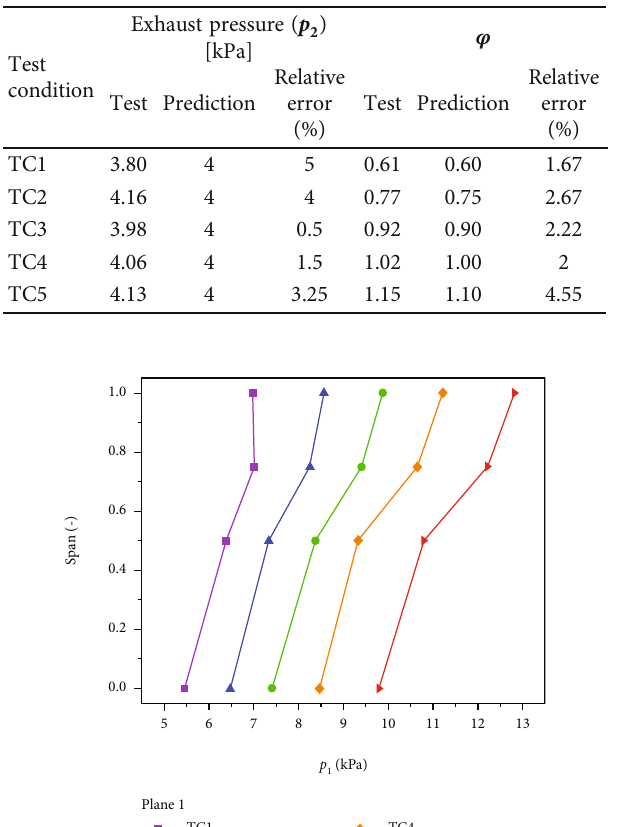
Table 2: Summary of test cases.